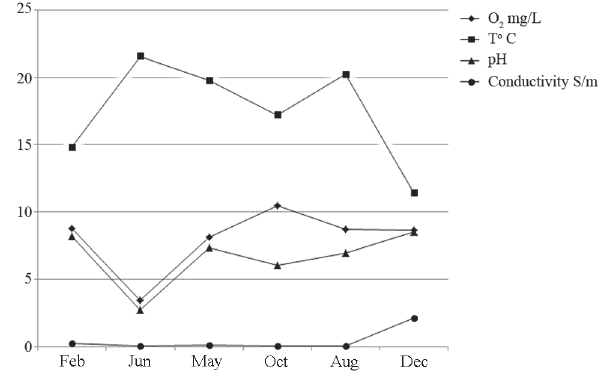
Fig. 2. Ombrothermic diagram for San Martin dam, Amealco, Qro. It shows hydrological periods of importance to the life cycle of